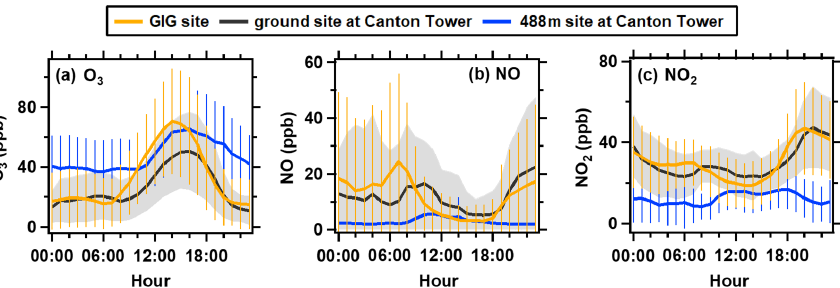
Figure 5. Diurnal variation of mean concentrations of (a) O 3 , (b) NO, (c) NO 2 at GIG (orange lines), and the ground and 488m sites of Canton Tower (black and blue lines, respectively). The orange and blue error bars represent the standard deviations of the mean concentrations at the GIG site and the 488m site of Canton Tower; the grey areas show 1 standard deviation of the mean concentration at ground site of Canton Tower.